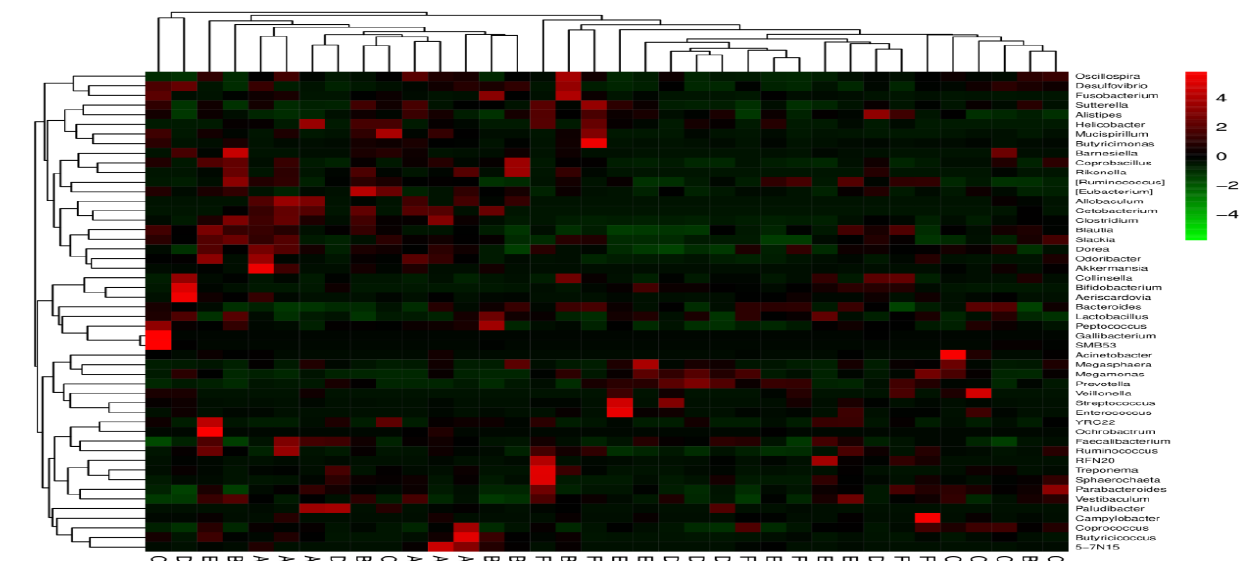
Figure 10. Heat map analyses of cecal samples and the heat map showing the abundances of the top 30 genera were clustered and plotted using R software. Green color represents genera with higher abundances in the corresponding sample, and red color represents genera with lower abundances.